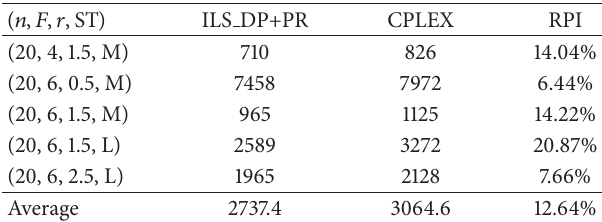
Table 10: Relative percentage improvement of ILS DP+PR with respect to CPLEX.